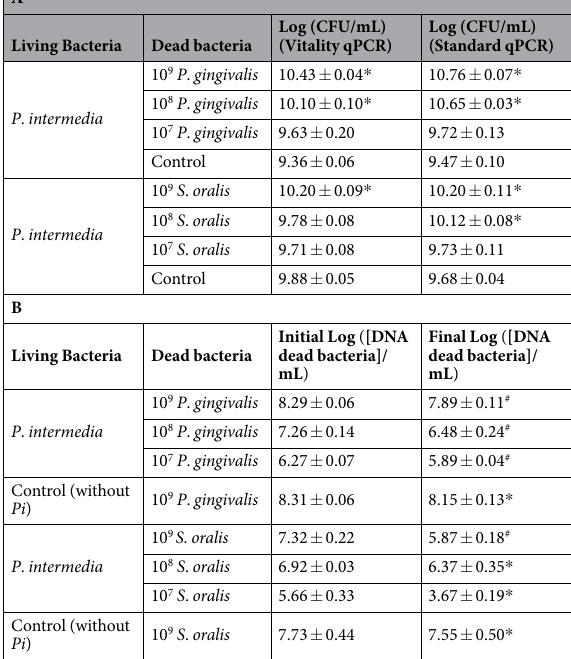
Table 2. Necrotrophic activity of P . intermedia and DNA concentrations of dead P . gingivalis and dead S . oralis (Log (MO/mL) analyzed by qPCR (mean ± standard deviation, n = 3). (A) Necrotrophic activity of P . intermedia in presence of dead P . gingivalis and dead S . oralis analyzed by standard and vitality qPCR. Control contains only living P. intermedia . * Designates a statistically significant outgrowth of P . intermedia respect to control (p < 0.05). (B) Initial and final concentrations of DNA from dead P . gingivalis and dead S . oralis during the necrotrophic activity of P . intermedia analyzed by standard qPCR. Control contains only DNA of dead bacteria. # Designates a statistically significant decrease of DNA from dead bacteria respect to control (p <